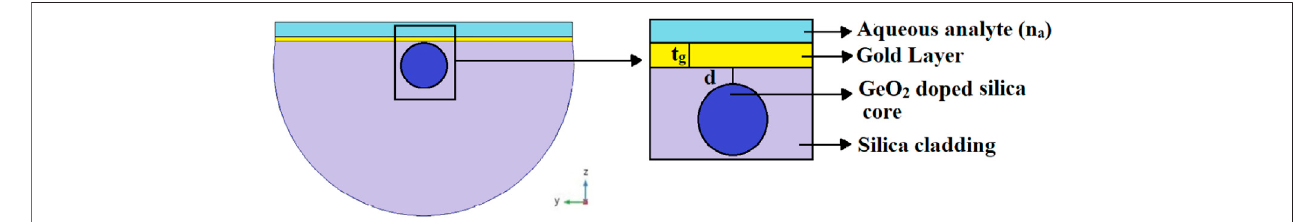
FIGURE 1 | Cross-sectional view of the proposed D-shaped optical fi ber RI